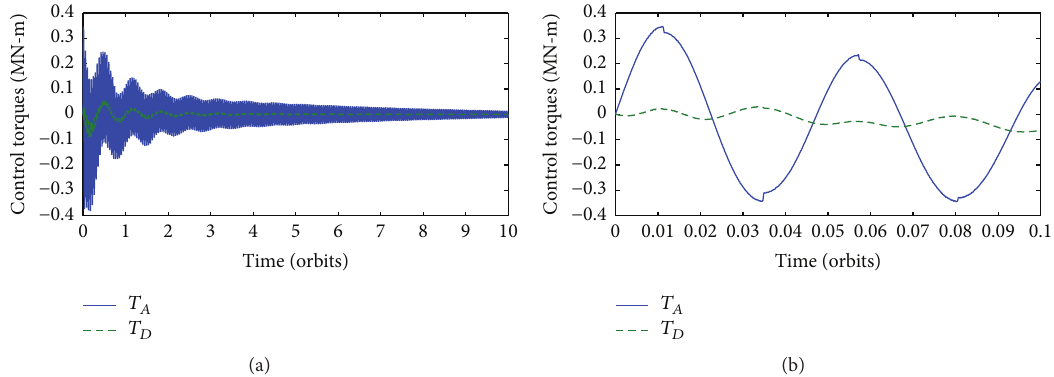
Figure 21: Control torques from the formulations based on point 𝐶 by applying the SDRE control with 𝛼 = 0 for (a) the first 10 orbits and (b) the first 0.1 orbits.